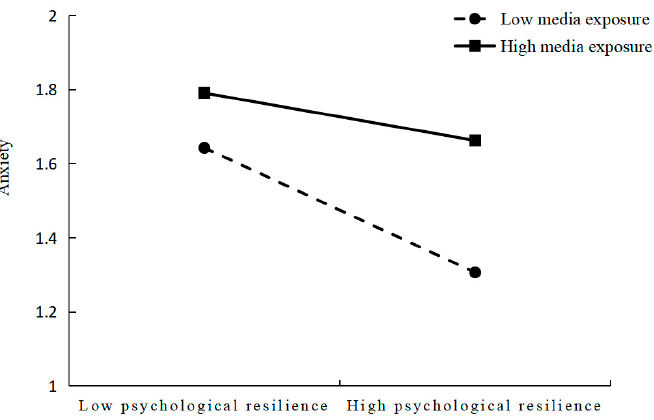
Figure 3. Interaction between psychological resilience and media exposure.